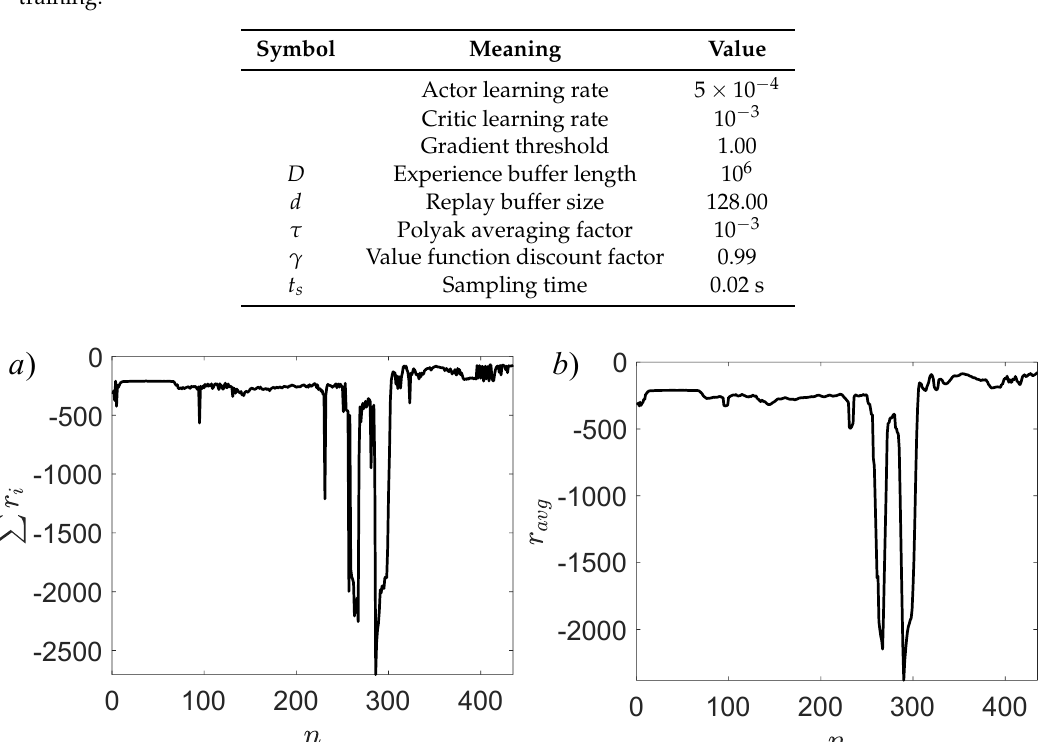
Table 1. Neural networks and Deep Deterministic Policy Gradient (DDPG) hyperparameters for the training.